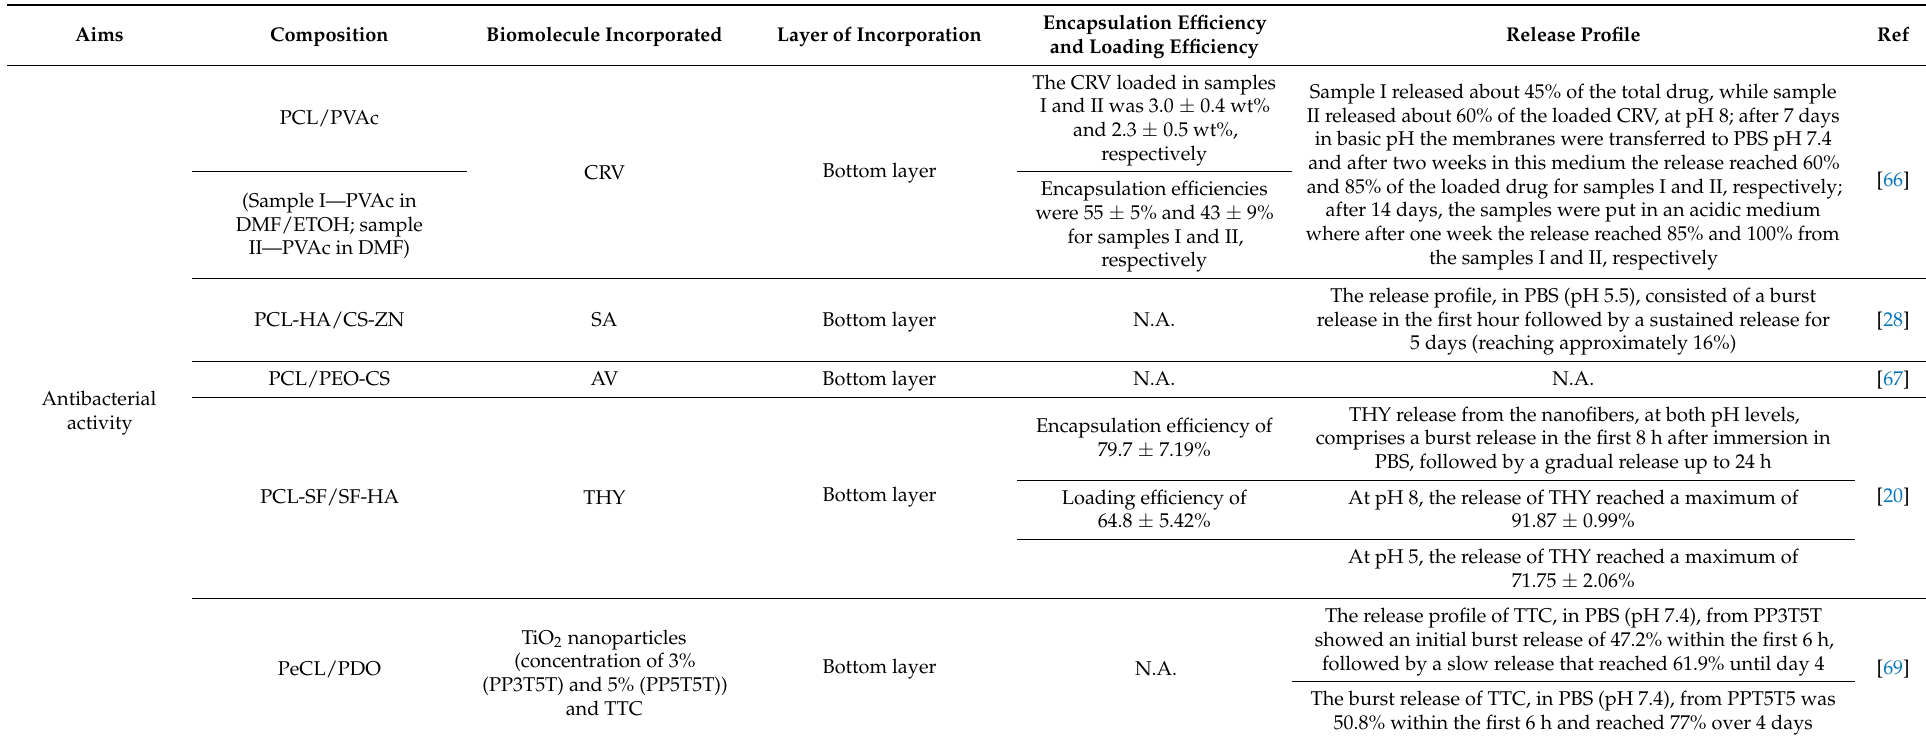
Table 3. Asymmetric membranes produced through electrospinning aimed to be used as biomolecules delivery